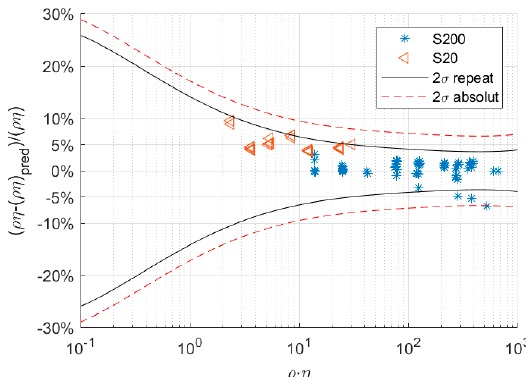
Figure 8. Relative deviation of the predicted and actual ρη value for the fluids S20 and S200, where ρ is the density and η is the dynamic viscosity. The full and dashed lines show the 95% confidence interval (2 σ ) for repeatability and absolute value, respectively.